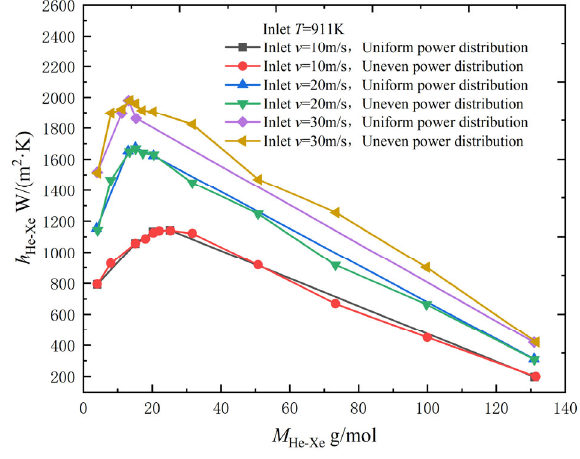
Figure 12. Variation of convective heat transfer coefficient of the helium–xenon gas mixture in the channel with the fuel rod’s heating power distribution [9].